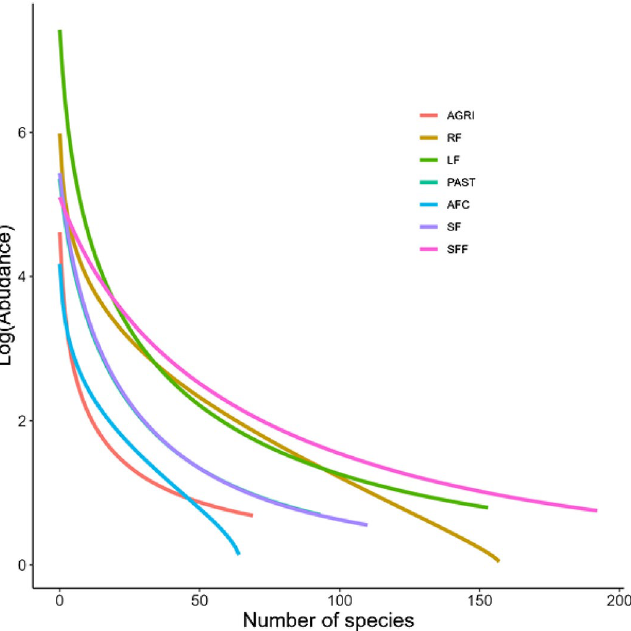
Figure 2. Species rank-abundance curves for each land use. The curves for the secondary forest (SF), secondary forest fragments (SFF), live fences (LF) and pasture (PAST) fit the Zipf-Mandelbrot model. The curves for riparian forest (RF) and agroforestry coffee (AFC) fit the Lognormal model, while the curve for agriculture (AGRI) fits the Zipf